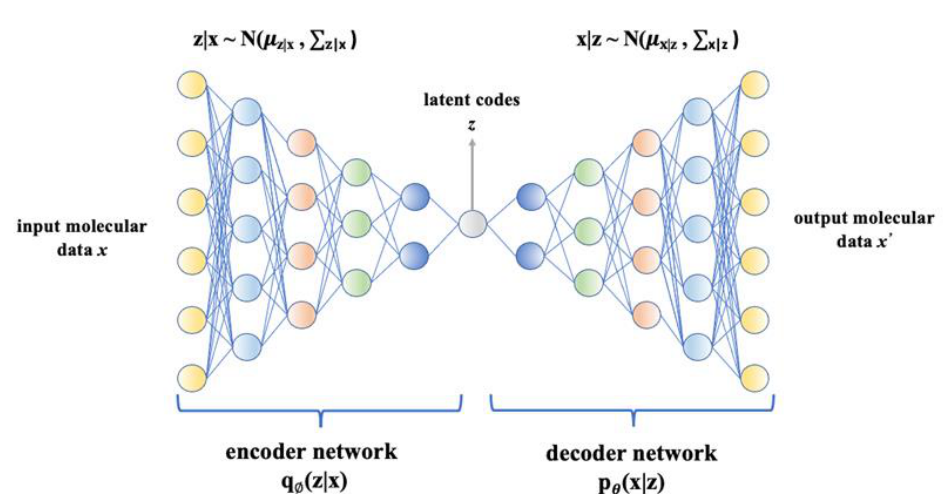
Figure 5. Variational autoencoder architecture. It consists of an encoder and a decoder, and they are deep neural networks. In general, the encoder maps input molecular data x into latent codes z by parameterizing a posterior distribution q Ø (z|x), and the decoder reconstructs molecular data from the learned distribution p θ (x|z).